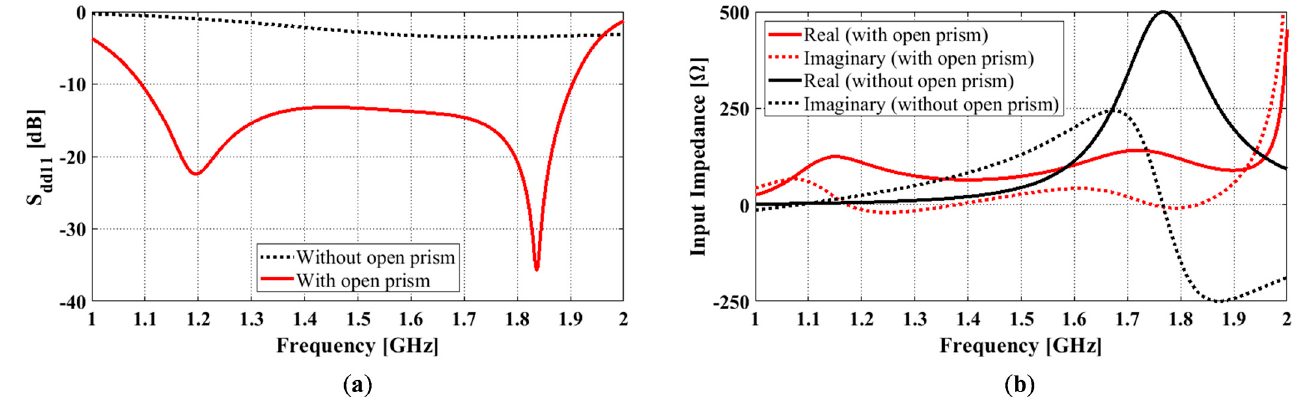
Figure 4. The octagonal cavity-backed antennas with and without the open prism: ( a ) Differential reflection coefficient; ( b ) Differential input impedance.